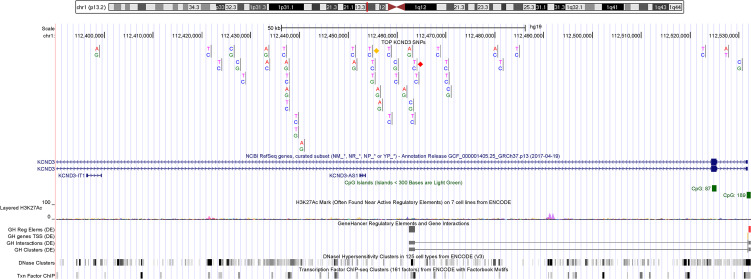
Location of the significantly (P < 5 × 10–8) associated SNPs within the KCND3 gene.The top 43 SNPs with a genome-wide significance visualized by UCSC Genome Browser (55). All 43 SNPs mapped into the KCND3 gene. The 2 leads SNPs, rs1545300 and rs12090194, of the discovery and combined meta-analyses are reported with a red and an orange diamond, respectively. The H3K27Ac mark track (Layered H3K27Ac) shows the levels of enrichment of the H3K27Ac histone mark. Chemical modifications (e.g., methylation and acylation) to the histone proteins present in chromatin influence gene expression by changing how accessible the chromatin is to transcription. The H3K27Ac histone mark is thought to enhance transcription, possibly by blocking the spread of the repressive histone mark H3K27Me3. The GeneHancer (GH) track set shows human regulatory elements, i.e., enhancers (gray) and promoters (red) containing tracks representing regulatory elements (Reg Elems), gene transcription start sites (TSS), associations between regulatory elements and genes (Interactions), and clustered interactions (Clusters). A gray box in the DNaseI hypersensitivity clusters track (DNase Clusters) indicates the extent of the hypersensitive region with darkness proportional to the maximum signal strength observed in any cell line. A gray box in the transcription factor ChIP-seq clusters track (Txn Factor ChIP) indicates a cluster of transcription factor occupancy, with the darkness of the box being proportional to the maximum signal strength observed in any cell line contributing to the cluster.